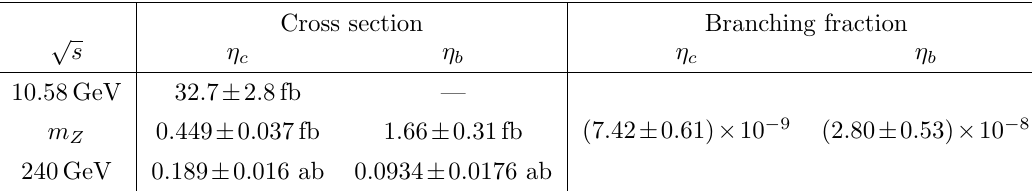
Table 1 . Cross sections (cid:27) ( e + e (cid:0) ! (cid:17) Q + (cid:13) ) and branching fractions Br( Z ! (cid:17) Q + (cid:13) ) for charmonium and for bottomonium with uncertainties including all input parameters as well as perturbative